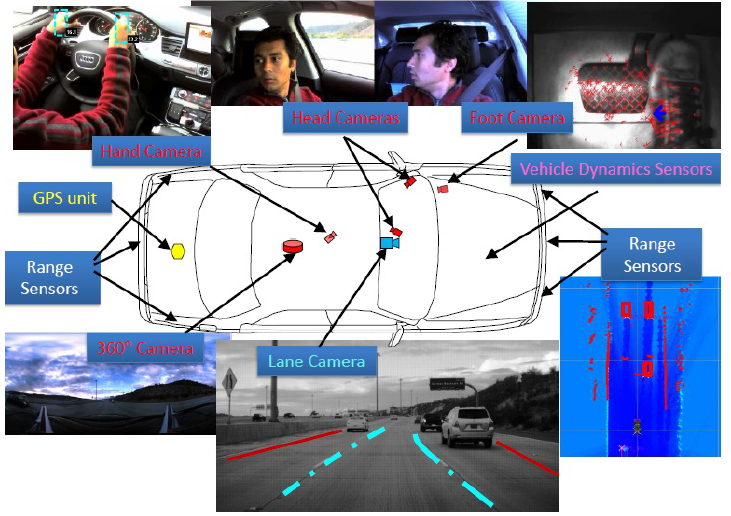
Figure 5. An example of on an Intelligent Vehicle used for data collection